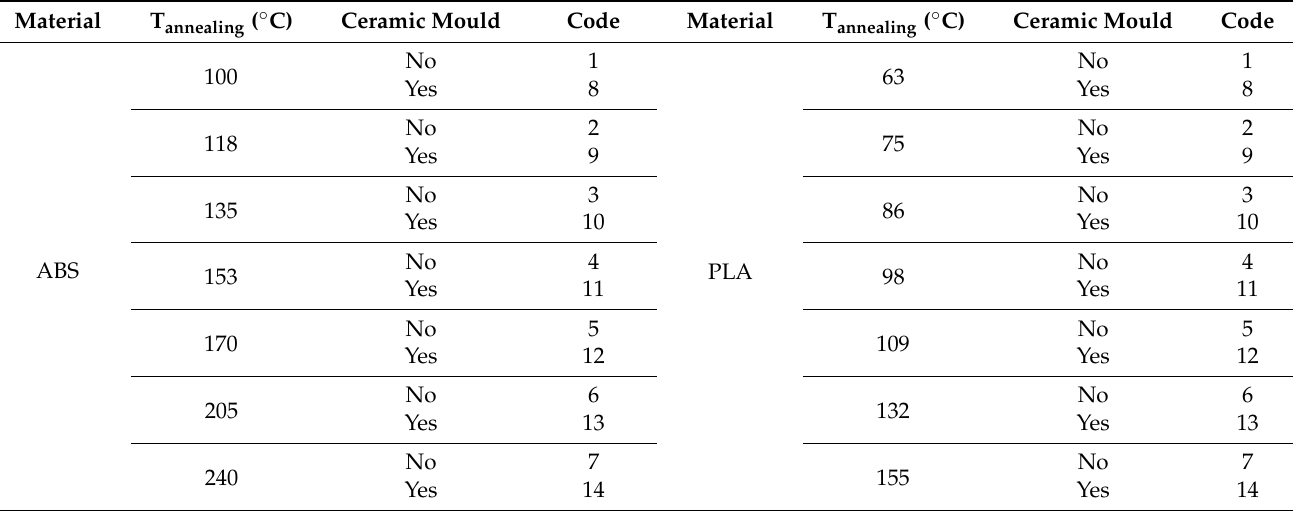
Table 3. ABS and PLA experiment